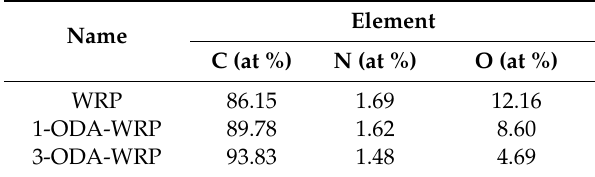
Table 5. Atomic number proportion of each element under the EDS test.